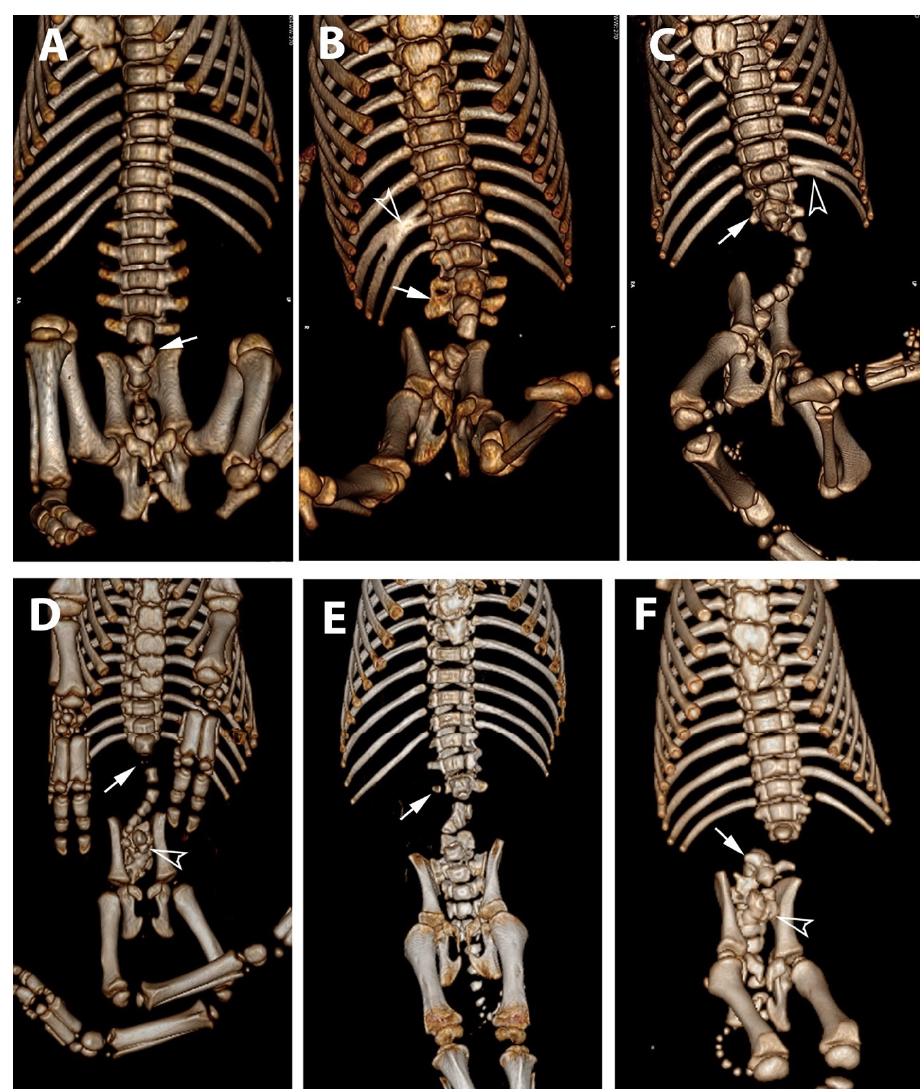
Figure 1. Ventral aspect of the skeleton on 3D-VR CT reconstructions with the spectrum of the malformations observed in piglets affected by Perosomus elumbis (the right side of the subjects is on the left). ( A ) Piglet #3: L6 (arrow) is present only as a bud. ( B ) Piglet #2: the lumbar tract shows a scoliotic curvature; L2-L3-L4 are irregularly fused (arrow); L5 and L6 are present as a bud; the right 14th and 15th ribs are partially fused (empty arrowhead); both the knees have an inverted angle. ( C ) Piglet #4: the lumbar tract shows a severe lordotic-scoliotic curvature; L1 is partially fused with T14 and L2 (arrow); the remnant lumbar vertebrae are present only as a bud; S1 is present as a small bud and the pelvis is tilted toward the left; there is also a partial fusion of the left 13th and 14th ribs (empty arrowhead) and a severe inversion of the left knee angle. ( D ) Piglet #5: L1 has only a slight mineralization of the body (arrow), the remnant lumbar vertebrae are present as buds with a complex lordotic-scoliotic curvature; the body of S1 is partially fragmented (empty arrowhead); the coccygeal vertebrae are absent; both the knees have an inverted angle. ( E ) Piglet #6: partial aplasia of L2 and L3 with a right fragmented lateral process (arrow); the remnant lumbar vertebrae (L4-L6) are present only as a bud. ( F ) Piglet #8: absence of the vertebrae from L2 to L4; L5 and L6 are partially fused (arrow); S1 and S2 were partially fused and irregularly fragmented (empty